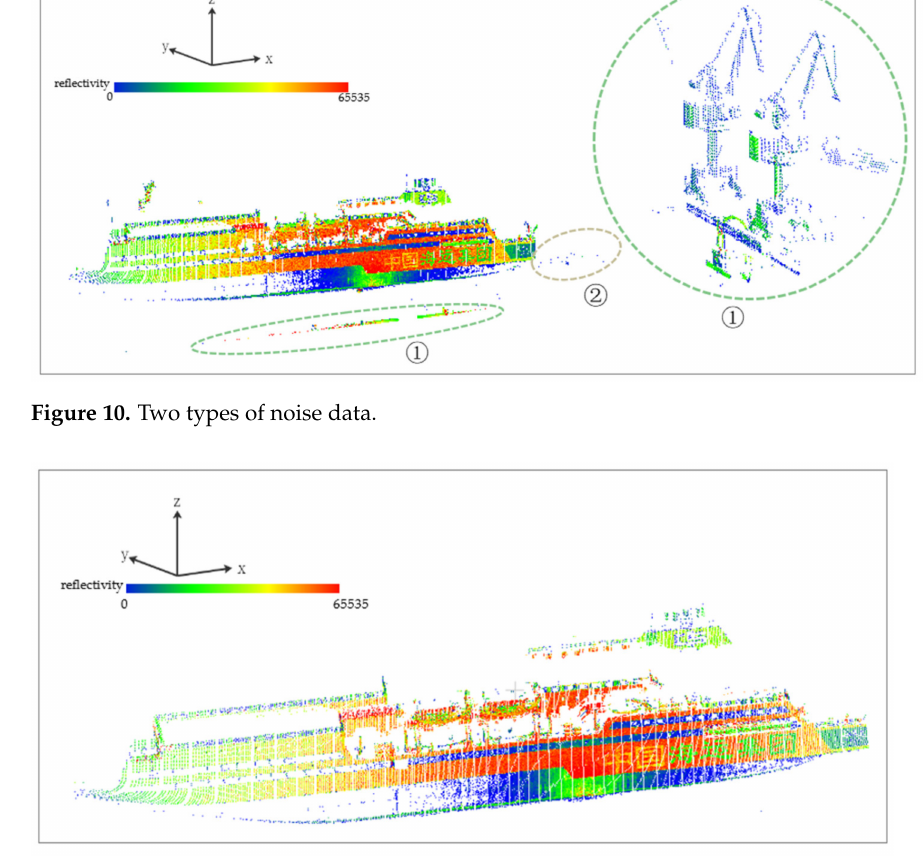
Figure 11. Result of data filtering.